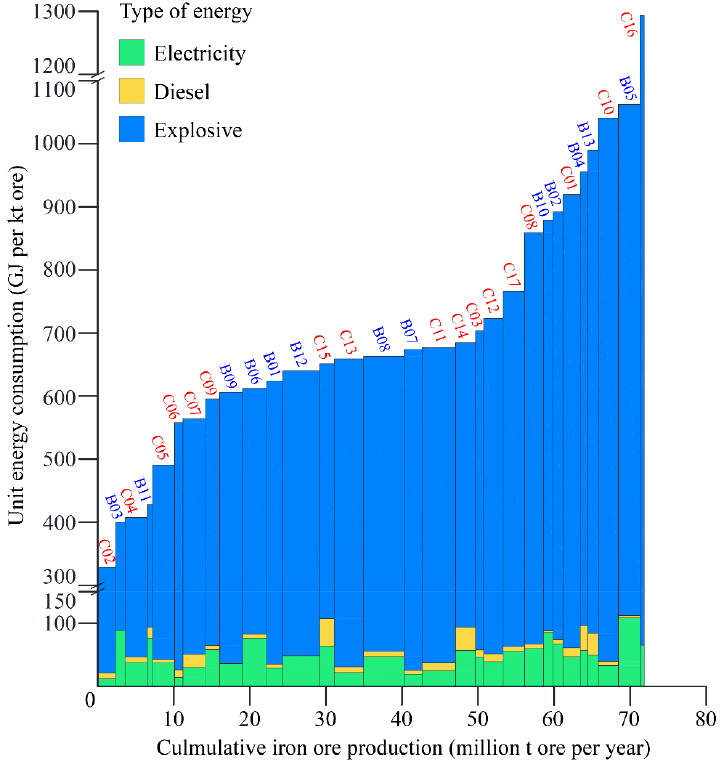
Figure 2. Energy intensity supply curve of the involved underground iron mines.